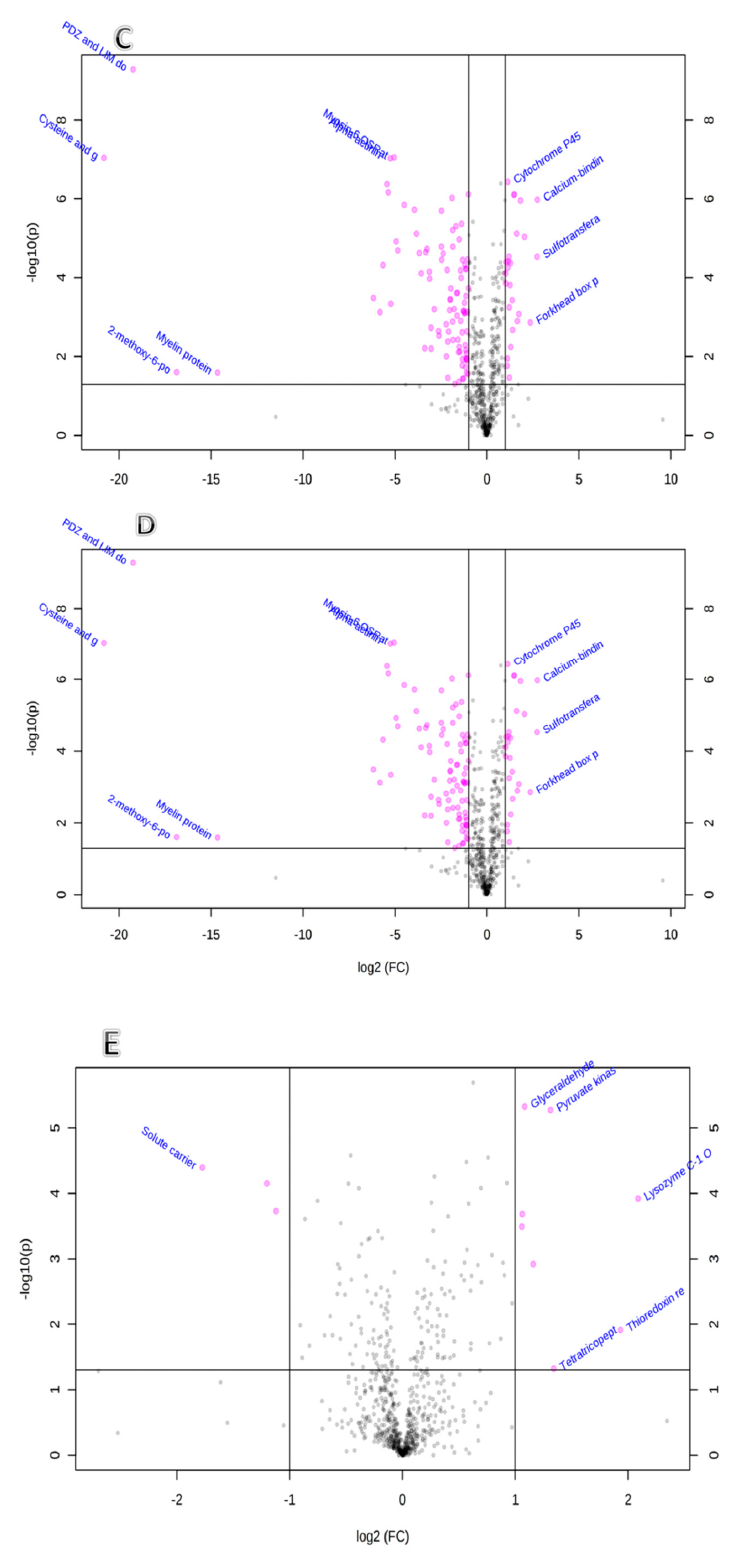
Figure 4. Plots showing the statistically significant expressed proteins in brain tissue ( A ), heart ( B ), skeletal muscle ( C ), liver ( D ), and kidney ( E ) after prolonged Dex administration false discovery rate (FDR-corrected p -value < 0.05), and fold change FC > 1.5 were visualized in each volcano plot in the left and right corners as down- and upregulated, respectively, in the Dex-treated